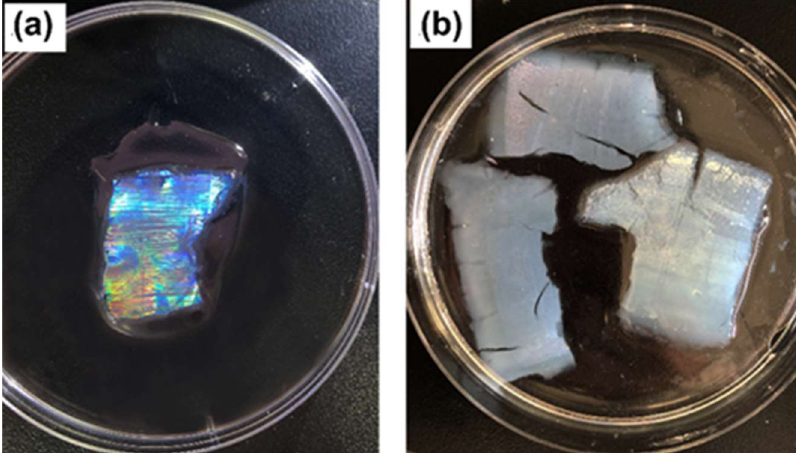
Figure 2. The SF-PNIPAM dual-crosslinked nanocomposite film at different crosslinking temperature ( a ) 20 °C; ( b ) 36 °C.